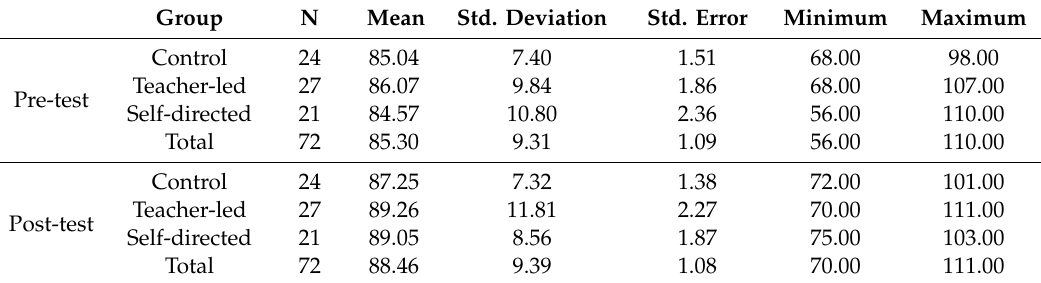
Table 2. Metacognitive Awareness Listening Questionnaire (MALQ) descriptive statistics.